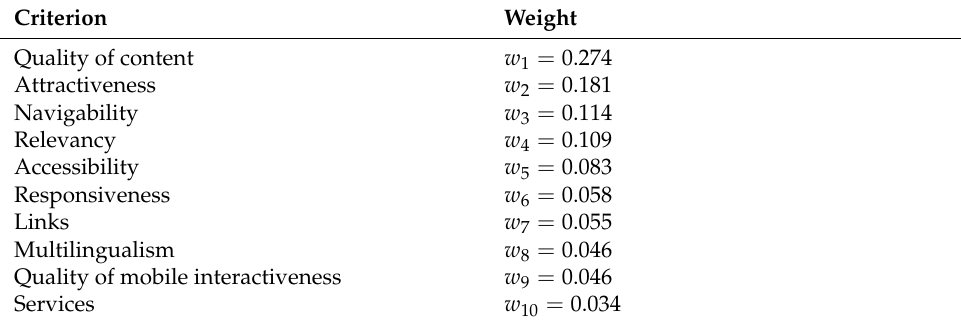
Table 2. The website criteria.